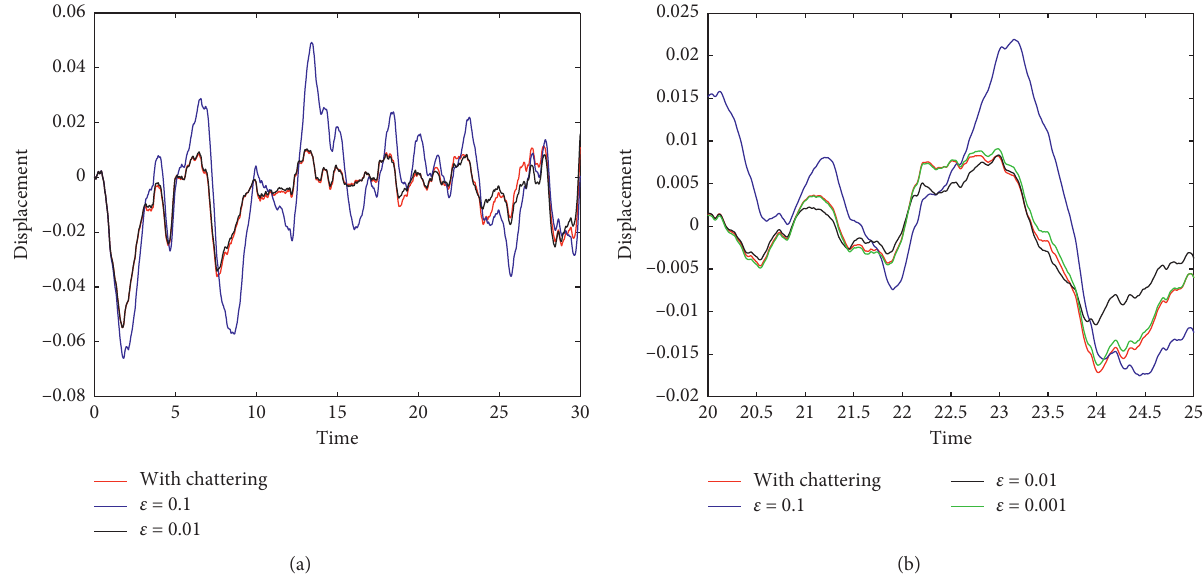
Figure 4: (a) Controlled system behavior for different magnitudes of ε . (b) Detailed view of Figure 4(a).